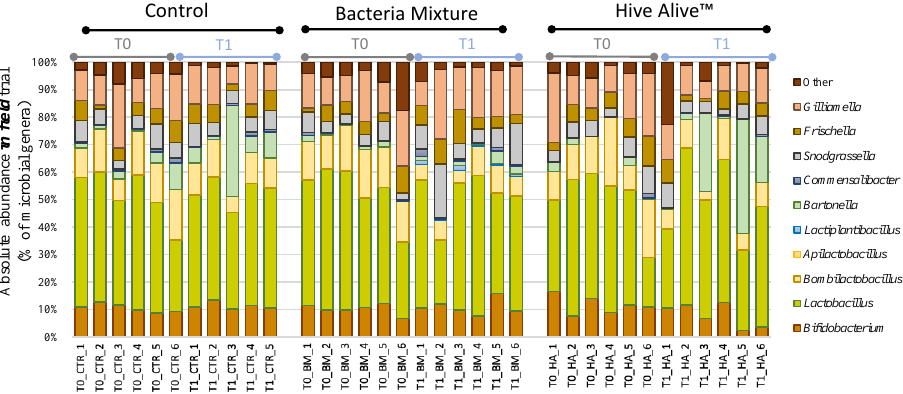
Figure 3. Absolute Abundance bar charts. Bar charts reporting the major cumulated microbial genera per samples and their absolute abundance expressed in percentage. Samples are reported with the sampling time T0 and T1, followed by the experimental conditions [CTR] Control, [BM] Bacterial Mixture and [HA] HiveAlive TM , and finally the replicate number